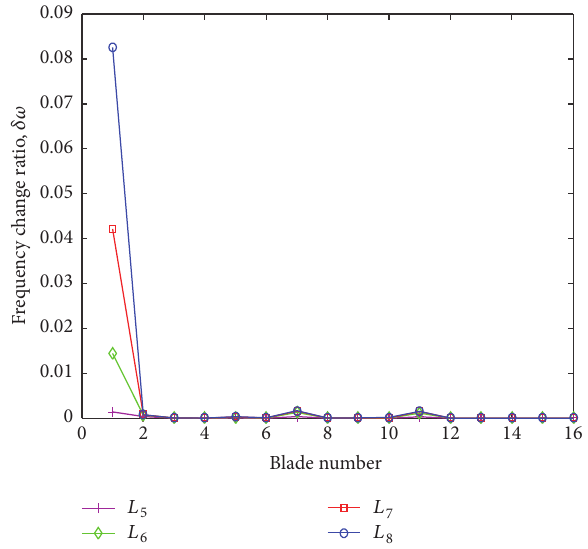
Figure 13: Frequencies change of MRBs under different 𝑙𝑐 .